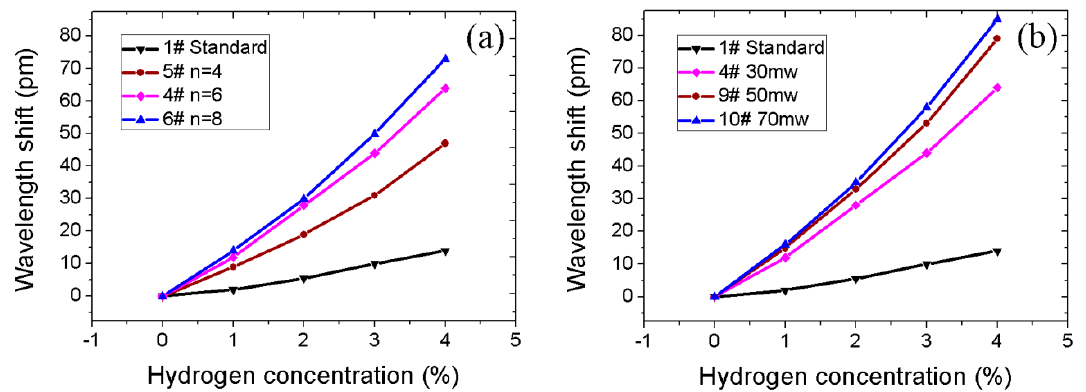
Figure 9. ( a ) Wavelength shift of sensors with different number of trenches; ( b ) Wavelength shift of sensors with different power.